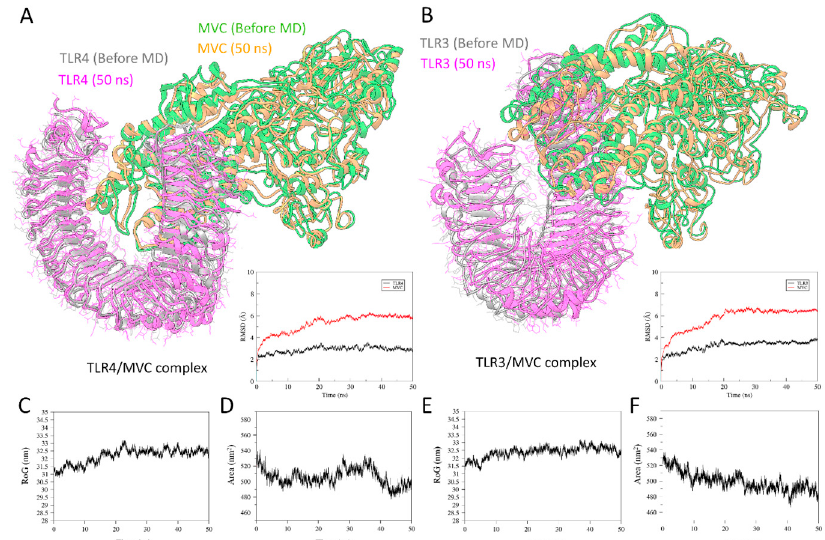
Figure 3. Toll-like receptor (TLR) complexed with a multiepitope vaccine construct (MVC). ( A ) Conformation of TLR4 / MVC and ( B ) TLR3 / MVC complex before and after 50 ns MD simulations, together with the RMSD plot at the bottom indicating the all-atom backbone deviation of TLR (in black) and MVC (in red). ( C ) Plot of radius of gyration (RoG) and ( D ) solvent-accessible surface area of TLR4 / MVC complex throughout 50 ns MD simulation and TLR3 / MVC ( E , F ).